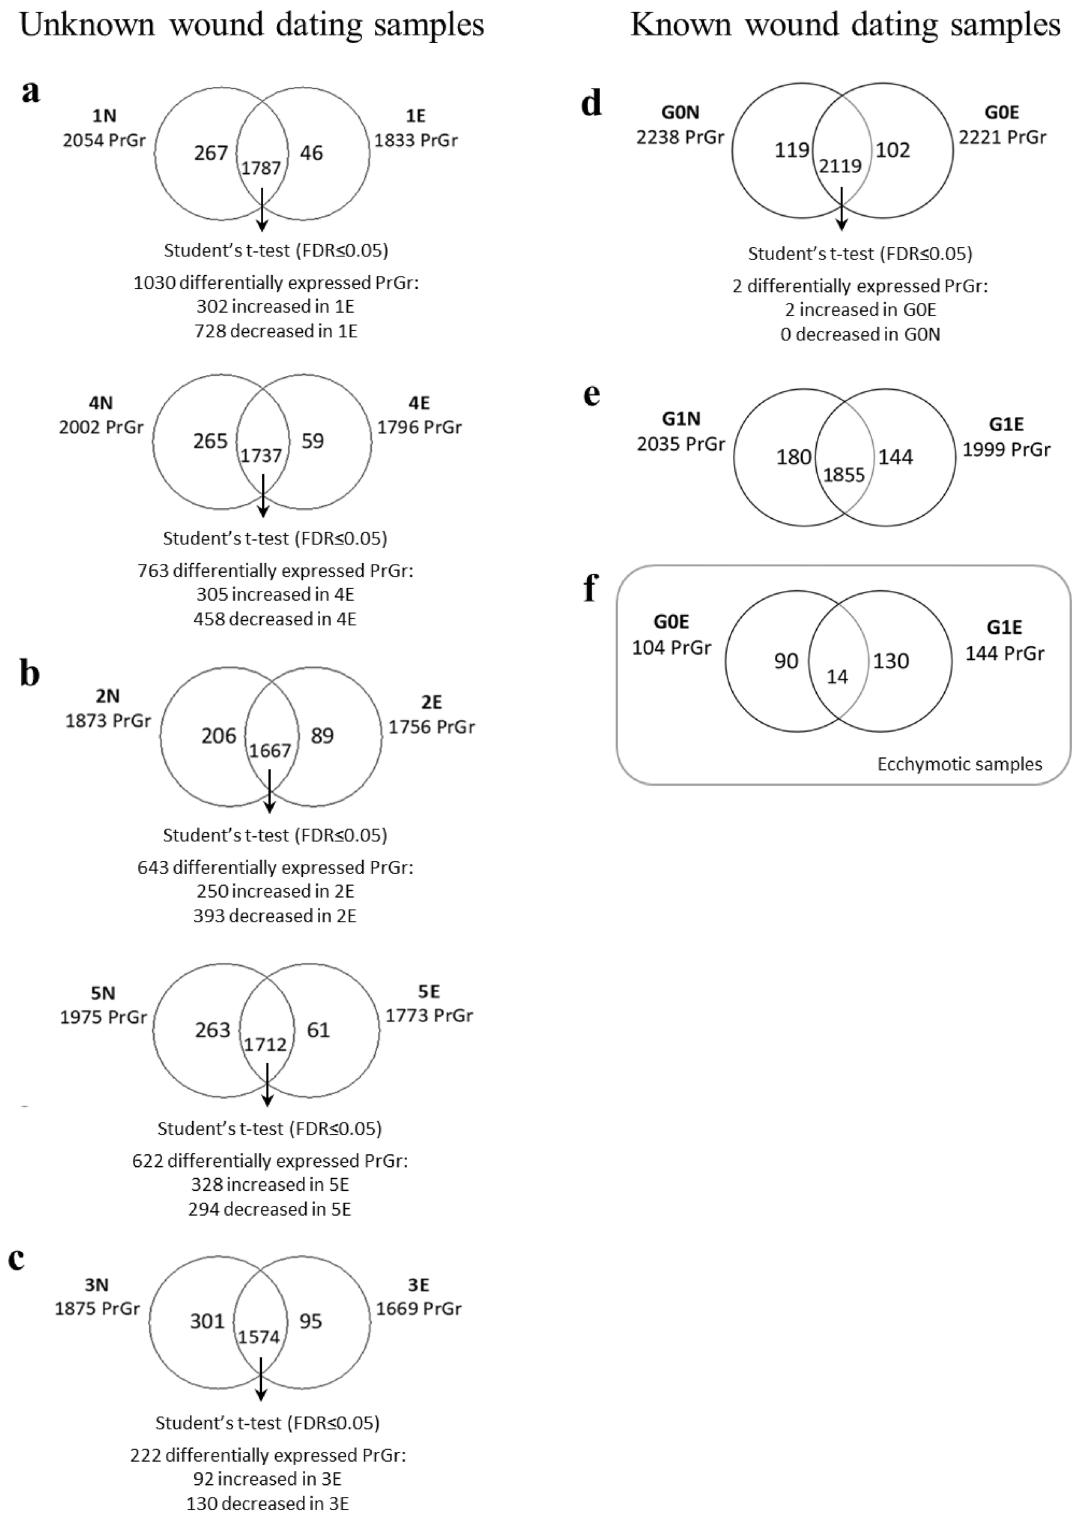
Figure 2. Venn diagrams of proteins identified in ecchymotic (E) and normal (N) skin in the comparisons: ( a ) 1E versus 1N and 4E versus 4N replicates; ( b ) 2E versus 2N and 5E versus 5N replicates; ( c ) 3E versus 3N; ( d ) G0E versus G0N; ( e ) G1E versus G1N; ( f ) G0E versus G1E. A statistical evaluation was applied for each comparison, where applicable. Proteins were considered to be differentially expressed if they were present only in one condition or showed significant t-test difference (Student’s t-test FDR ≤